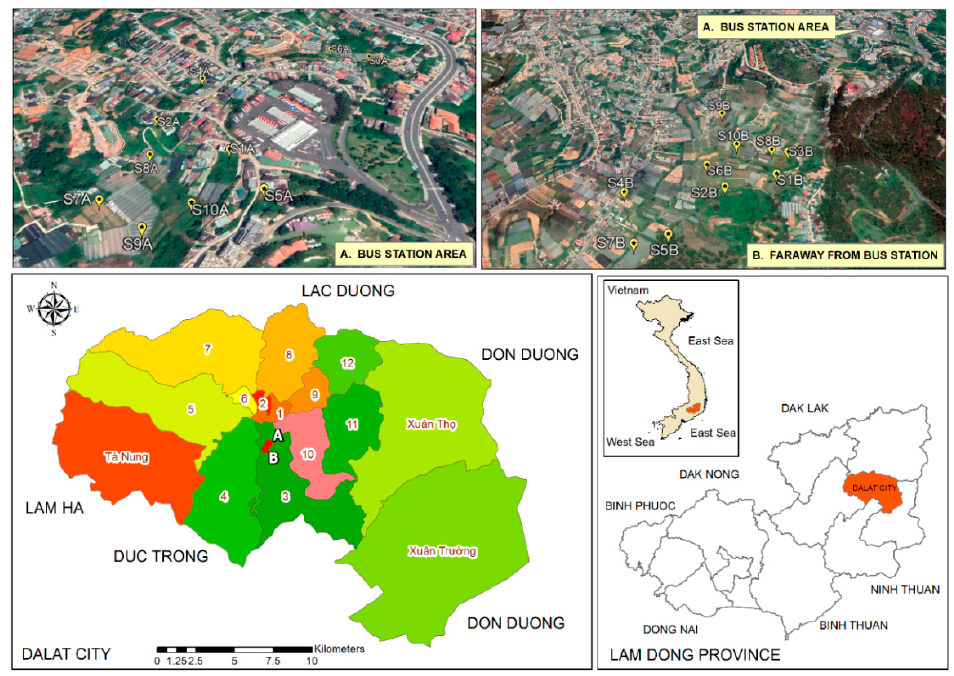
Figure 1. Study area in Dalat city and the location of sampling points.